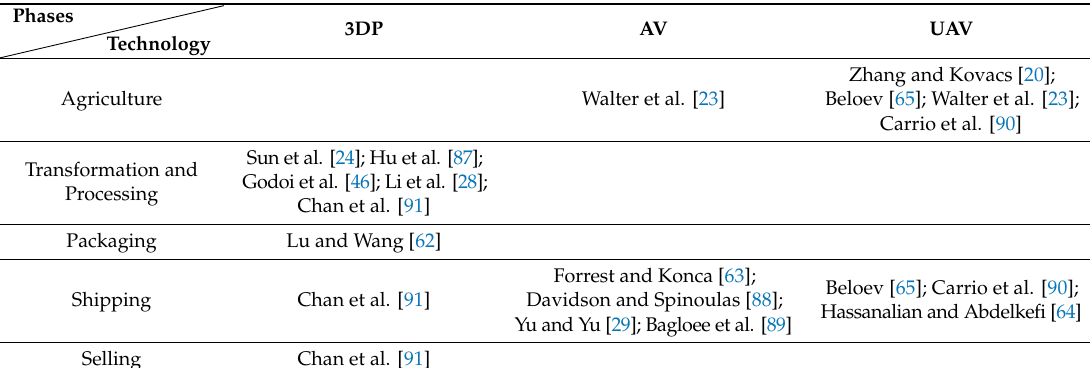
Table 3. Emerging technologies and their implementation in phases of the food supply